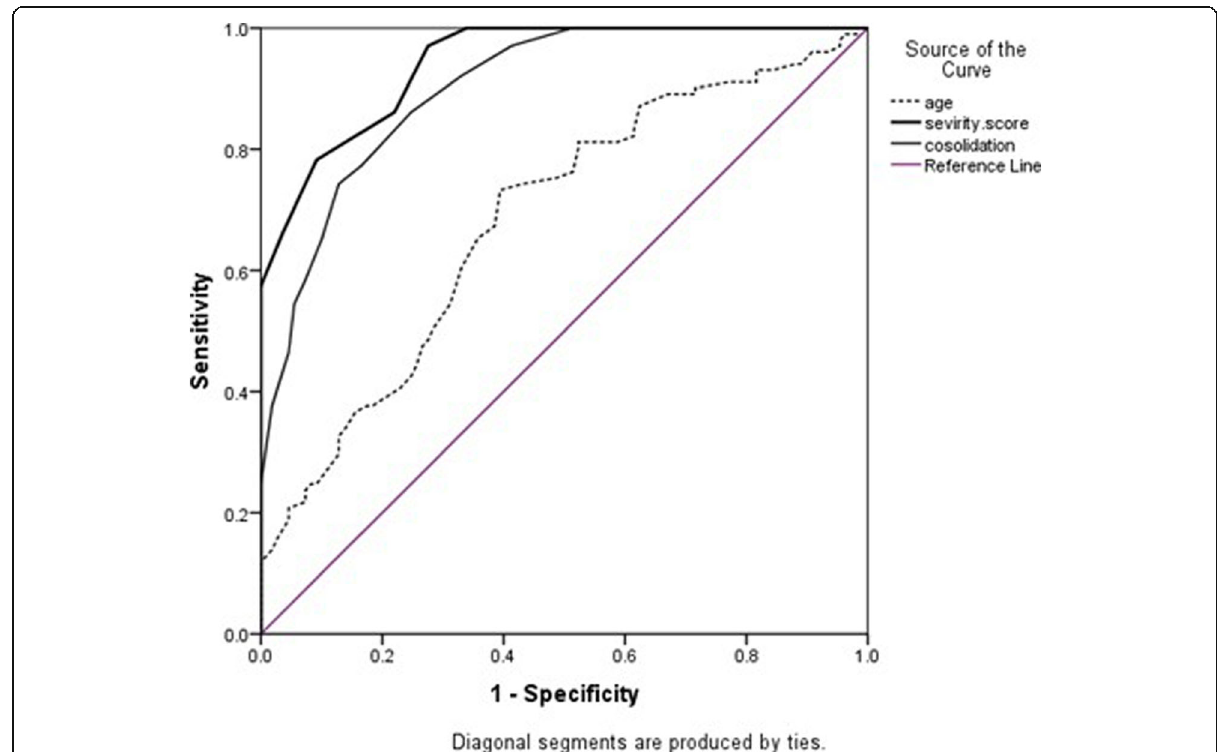
Fig. 10 ROC curve for age, chest CT severity, and consolidation/crazy-paving scores as a predictor for post-COVID-19 fibrosis to detect the sensitivity and specificity of these